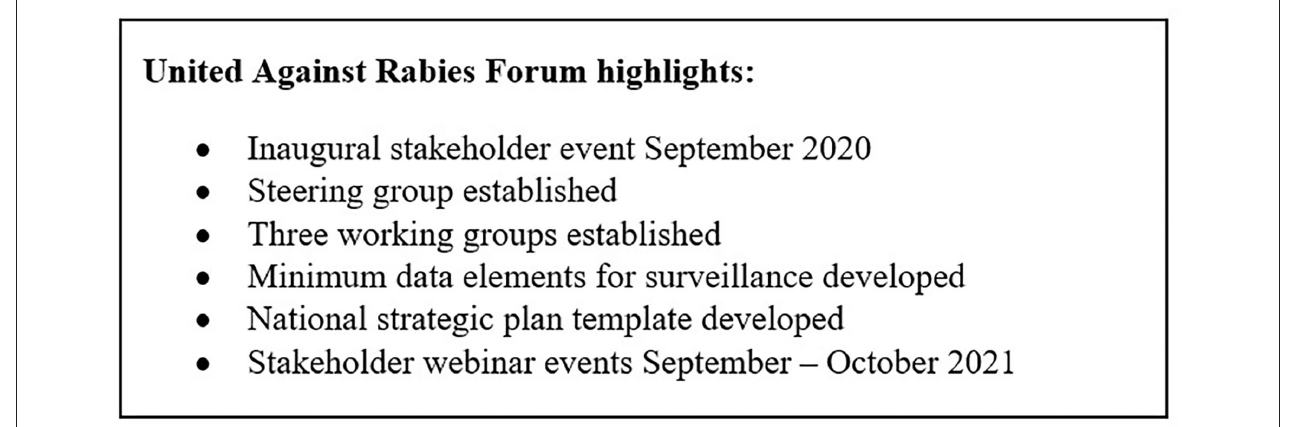
FIGURE 1 | United Against Rabies Forum